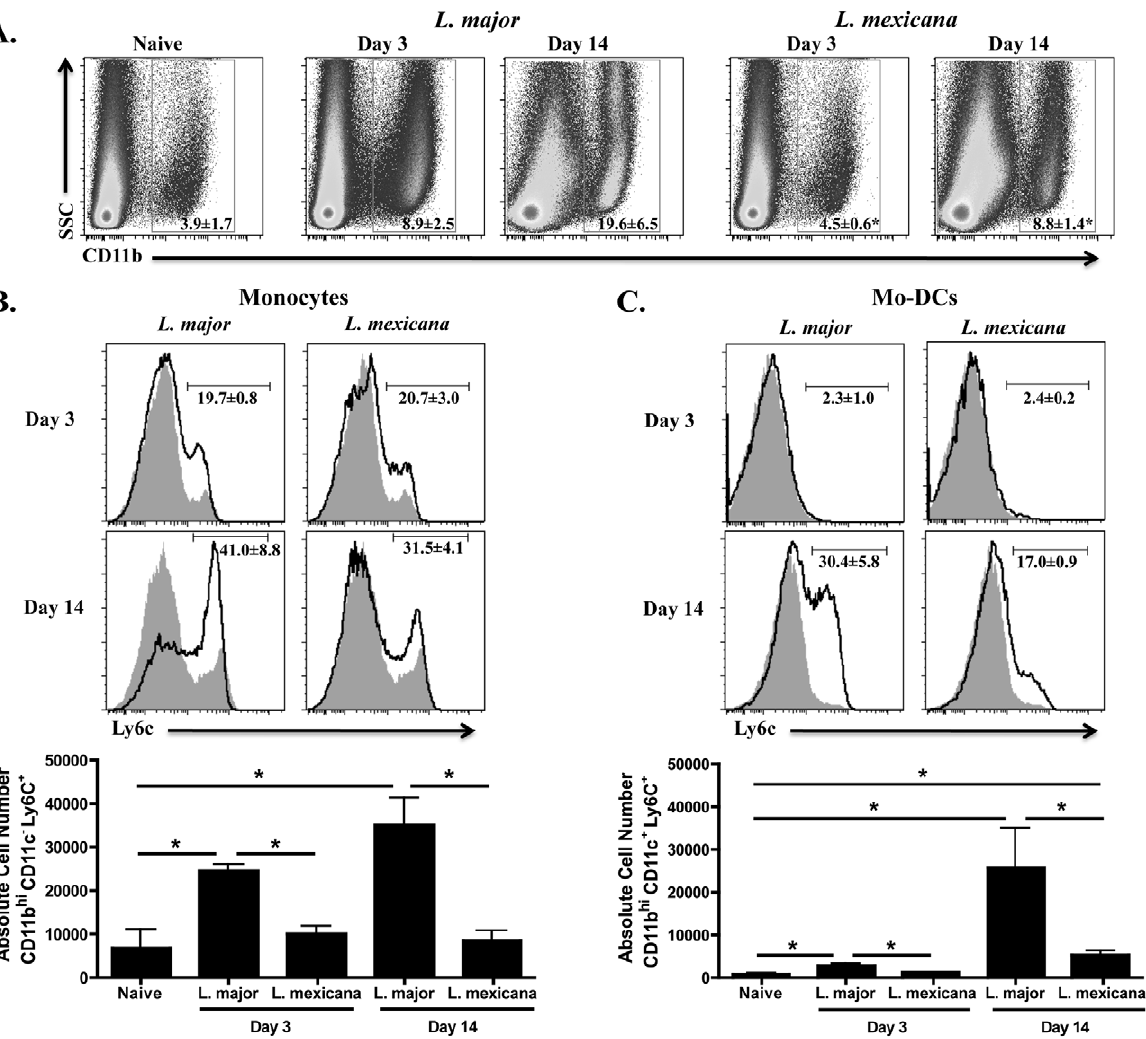
Figure 1. Fewer CD11b hi Ly6C + cells in the ear following L.mexicana infection compared to L.major . Ears from naı¨ve, as well as L. major or L. mexicana infected C57BL/6 mice were processed to single cell suspensions. ( A ) Percentage of CD11b hi cells present in the ear of naı¨ve or infected mice on day 3 and 14. Cells are previously gated on total, single live cells. Histograms of monocytes ( B ) or mo-DCs ( C ) in the ear of naı¨ve (grey shaded histogram) or infected mice (black line) on day 3 and 14 and absolute number of monocytes ( B ) or mo-DCs ( C ) from naı¨ve, day 3 and day 14 infected mice. Monocytes are pre-gated on CD11b hi CD11c 2 cells and mo-DCs are previously gated on CD11b hi CD11c + cells. The results expressed are the mean percentage ( 6 SD for FACS plots) or the mean number of cells ( 6 SE for bar graphs) of 3 mice per group. The results are representative of two experiments. * significantly lower (p , 0.05) compared to L. major infected mice in Fig. 1A or p , 0.05 between indicated groups in Fig. 1B and C.